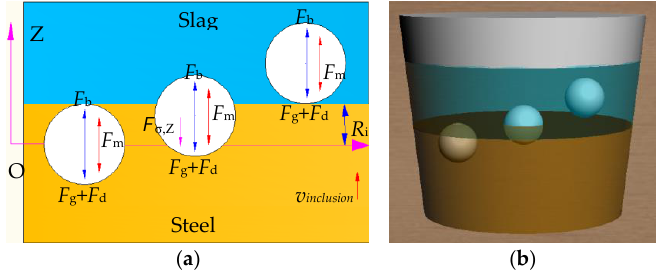
Figure 23. The schematic diagram of the force analysis of inclusions. ( a ) Force analysis of inclusions passing through steel slag interface; ( b ) Three dimensional simulation of inclusions passing through steel slag interface.